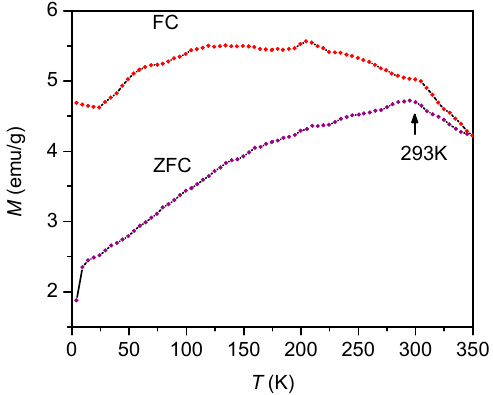
Figure 8. Zero-field-cooled (ZFC) and field-cooled (FC) magnetization measurements of Sr 3 Co 2 Fe 24 O 41 powder in a magnetic field of 100 Oe.